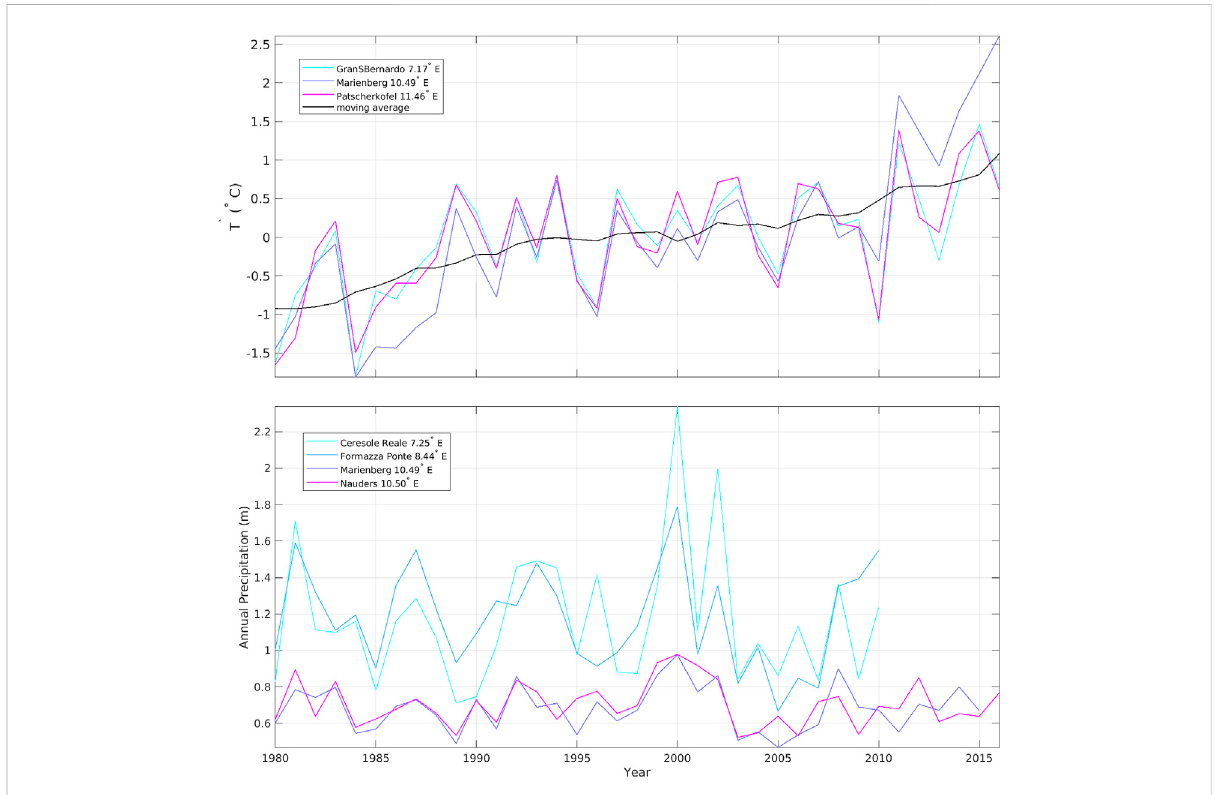
FIGURE 2 Time series of experimental air temperature variations (top panel) and annual total precipitation (bottom panel) from the in situ stations